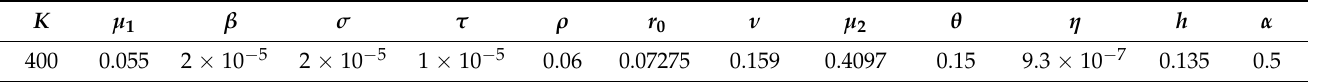
Table 3. Real parameters for P. radiata .